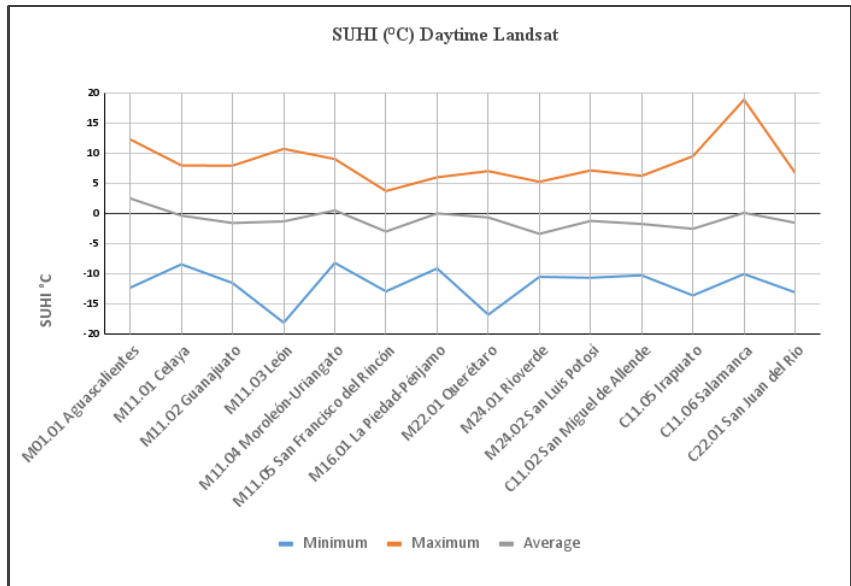
Figure 5. Surface Urban Heat Islands in Metropolitan and Conurbated Areas Calculated Using Daytime Landsat Images.